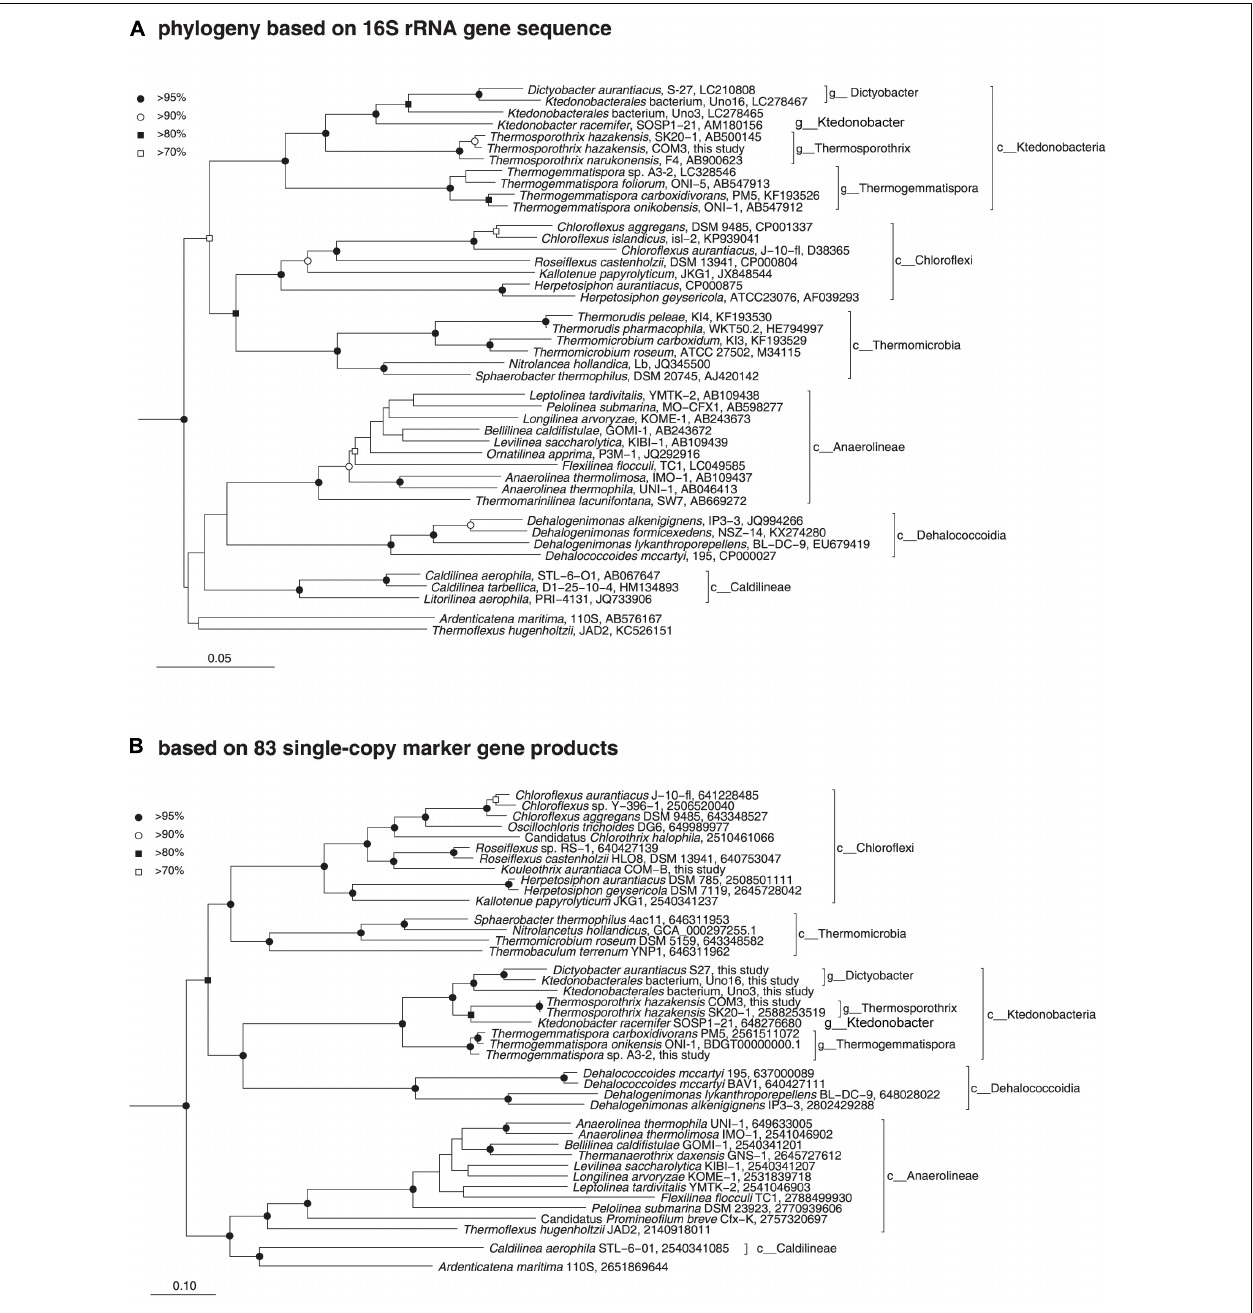
FIGURE 3 | Phylogenetic positions of the members of the class Ktedonobacteria based on comparative analysis of 16S rRNA gene sequences (A) and conserved protein sequences (B) . (A) Neighbor-joining phylogenetic tree of public data (accession numbers are shown at the end of the index of each note) and the 16S rRNA gene sequence of T. hazakensis COM3, which was extracted from the genome sequence obtained in this study. Sequences from the bacterial phylum Nitrospira were used to root the tree (not shown). Reproducible nodes are marked based on bootstrap values from neighbor-joining and maximum-likelihood inferences (closed circle, > 95% for both inferences; open circle, > 90%; closed square, > 80%; open square, > 70%). Nodes that lack symbols were not reproducible among trees. Bar: 5% estimated sequence divergence. (B) Maximum-likelihood phylogenetic inference of representative genomes of the class Chloroflexi . The tree was built using RAxML based on up to 83 universally conserved proteins. Reproducible associations based on bootstrap values (closed circle, > 95% for both RAxML and FastTree inferences; open circle, > 90%; closed square, > 80%; open square, > 70%) are indicated at interior nodes. Accession numbers of genomes (IMG or DDBJ/EMBL/GenBank databases) are shown at the end of the index of each taxon. Alignments of homologous proteins from genomes of members of the phylum Deinococci were used to root the tree (not shown). Bar: 10% estimated sequence divergence.